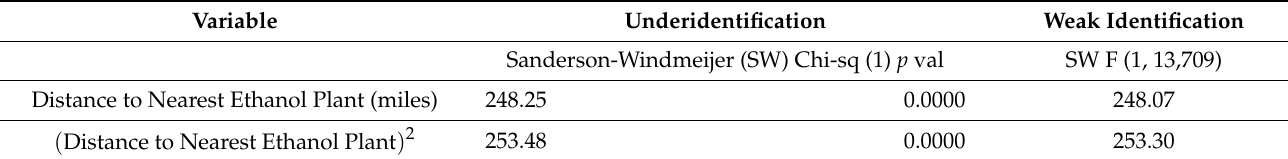
Table 3. Tests for underidentification and weak instruments.